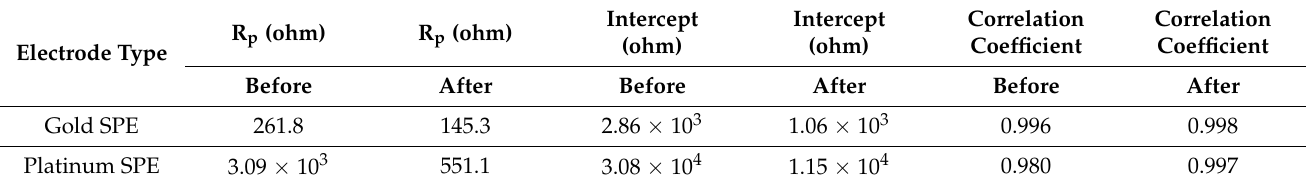
Table 4. EIS measurements frequency ranges from 0.1 MHz to 100 kHz, alternating current with an amplitude of 10 mV, before and after the treatment with absolute ethanol .